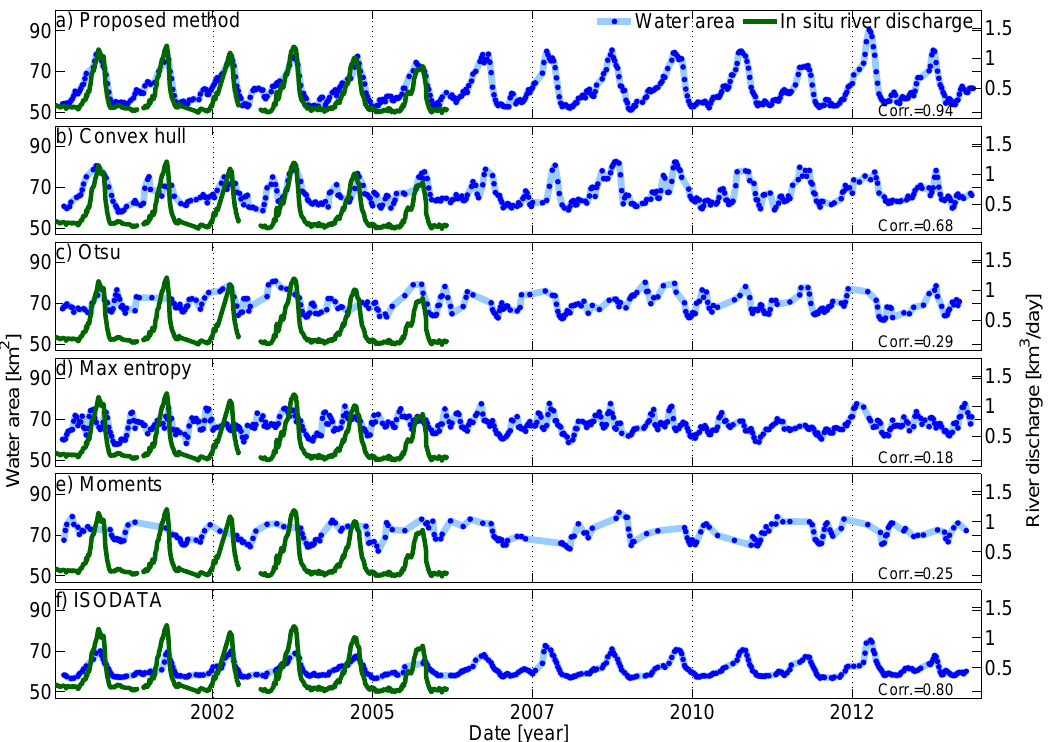
Figure 23. ( a – f ) Comparison of different classification algorithms on the same data set. Monitoring period: February 2000–September